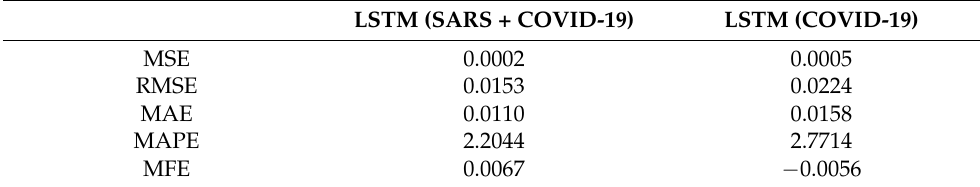
Figure 15. LSTM COVID-19 Forecasting Result After COVID-19 Pandemic with One-Day- ( a ) and Five-Day-Ahead ( b ) Forecast. Table 15. The Value of Each Measure for COVID-19 Period with One-Day-Ahead Forecast.